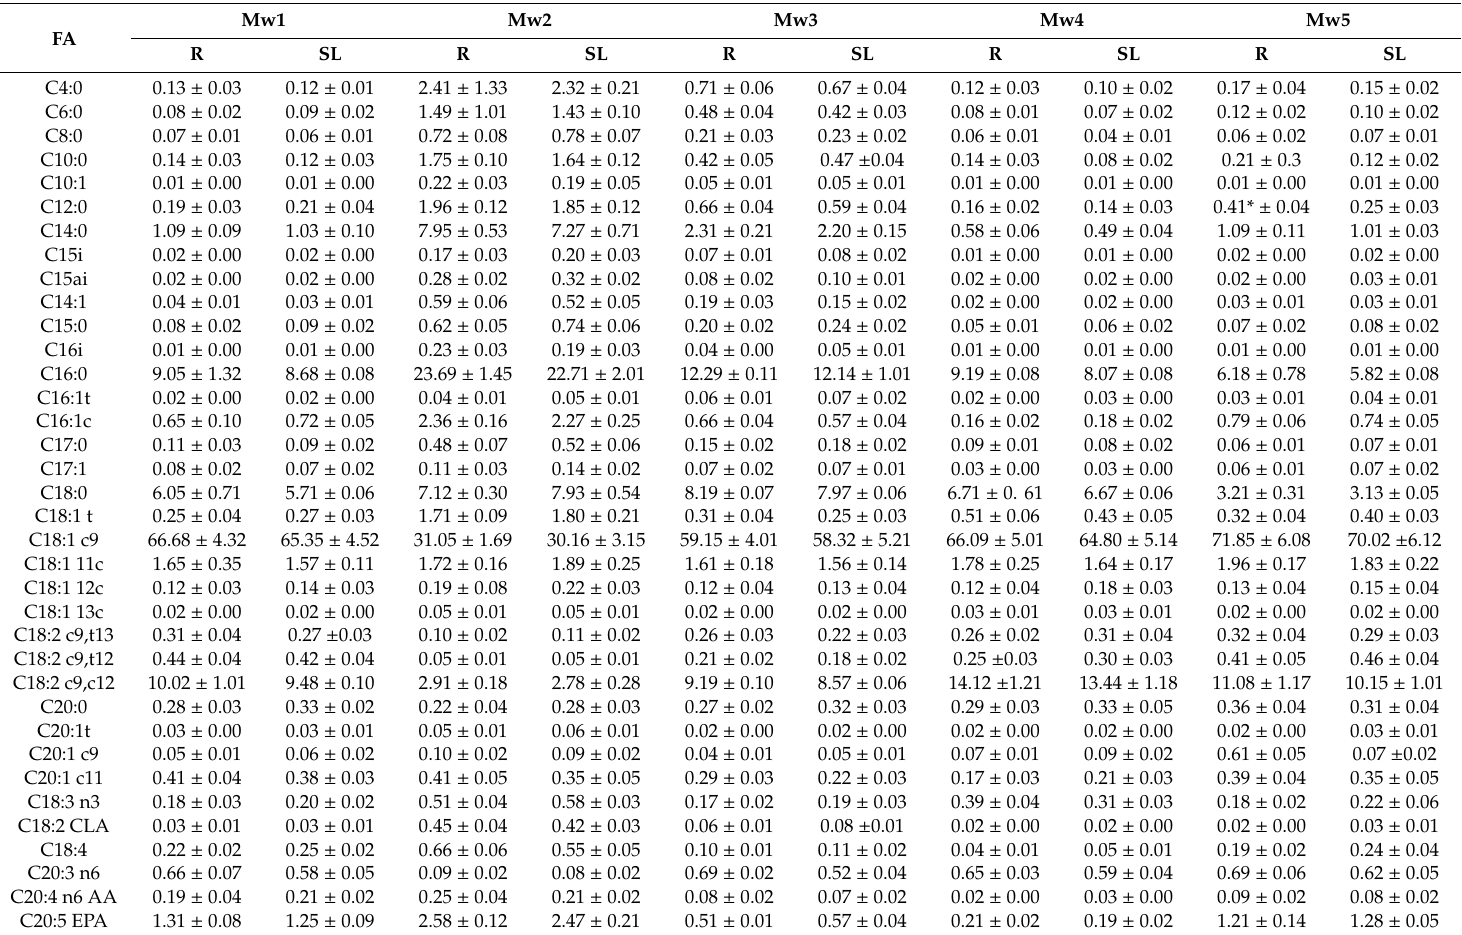
Table 3. Fatty acid composition (g FA / 100 g of total FA ± Standard Deviation (SD) at the reception (R) and at the end of the shelf life (SL) in commercial PUFA UHT-enriched